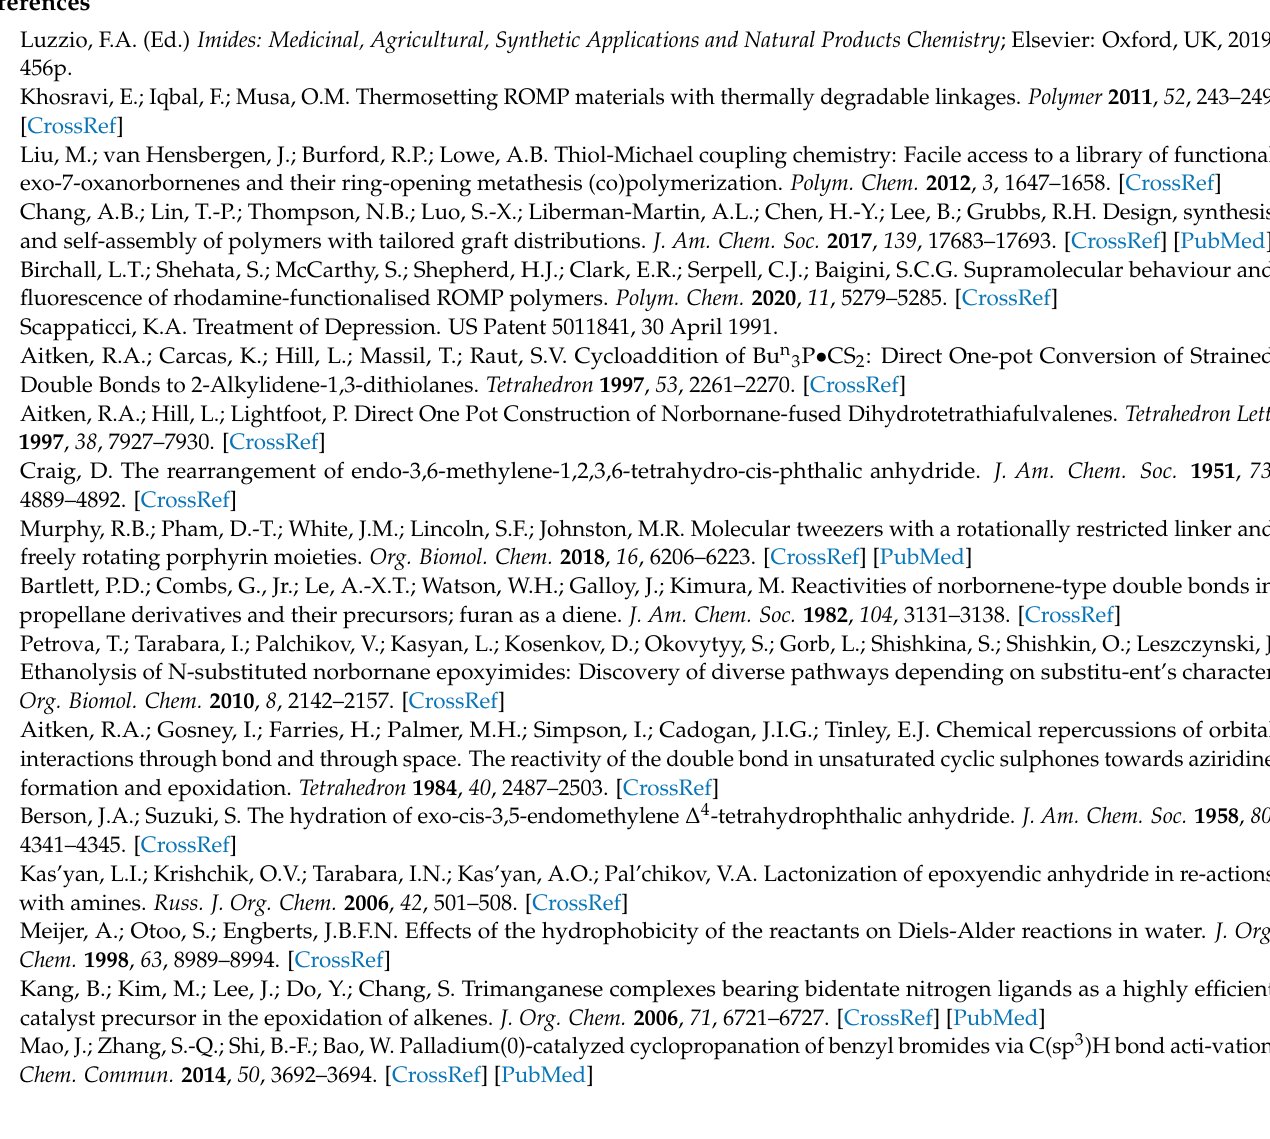
Figure S2: 13 C-NMR spectrum of 2 ; Figure S3: HSQC 2D C–H correlation NMR spectrum of 2 ; Figure S4: 1 H-NMR spectrum of 3 ; Figure S5: 13 C-NMR spectrum of 3 ; Figure S6: HSQC 2D C–H correlation NMR spectrum of 3 ; Figure S7: IR spectrum of 3 ; Figure S8: 1 H-NMR spectrum of 4 ; Figure S9: 13 C-NMR spectrum of 4 ; Figure S10: HSQC 2D C–H correlation NMR spectrum of 4 ; Figure S11: IR spectrum of 4 . Cif and check-cif files for compound 3